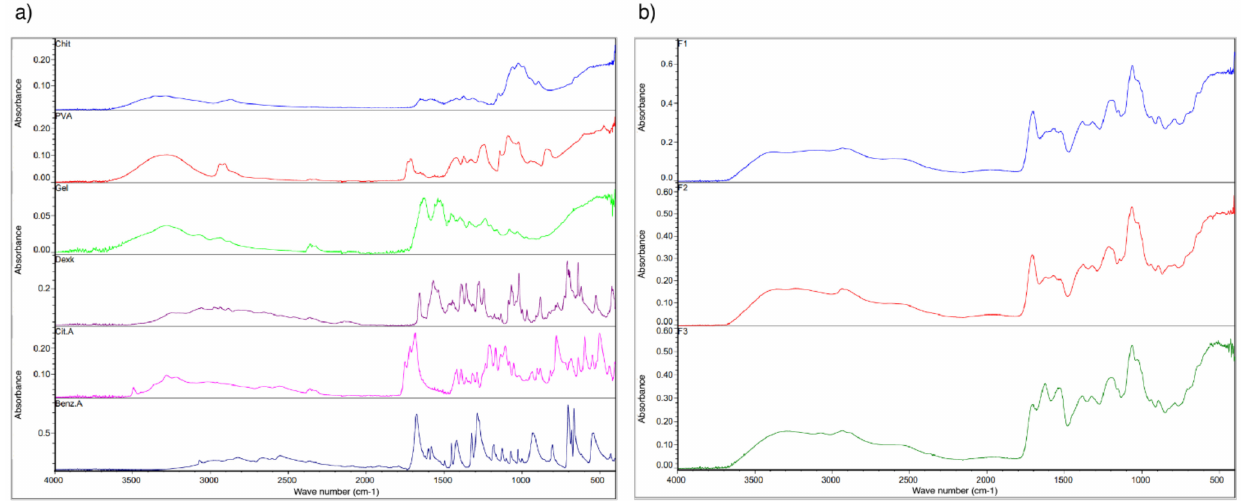
Figure 3. FT-IR spectroscopic analysis; ( a ) raw materials: chitosan (blue), PVA (red), gelatin (green), DKT (purple), citric acid (fuchsia), and benzoic acid (blue); ( b ) formulation prototypes: F1 (blue), F2 (red), and F3